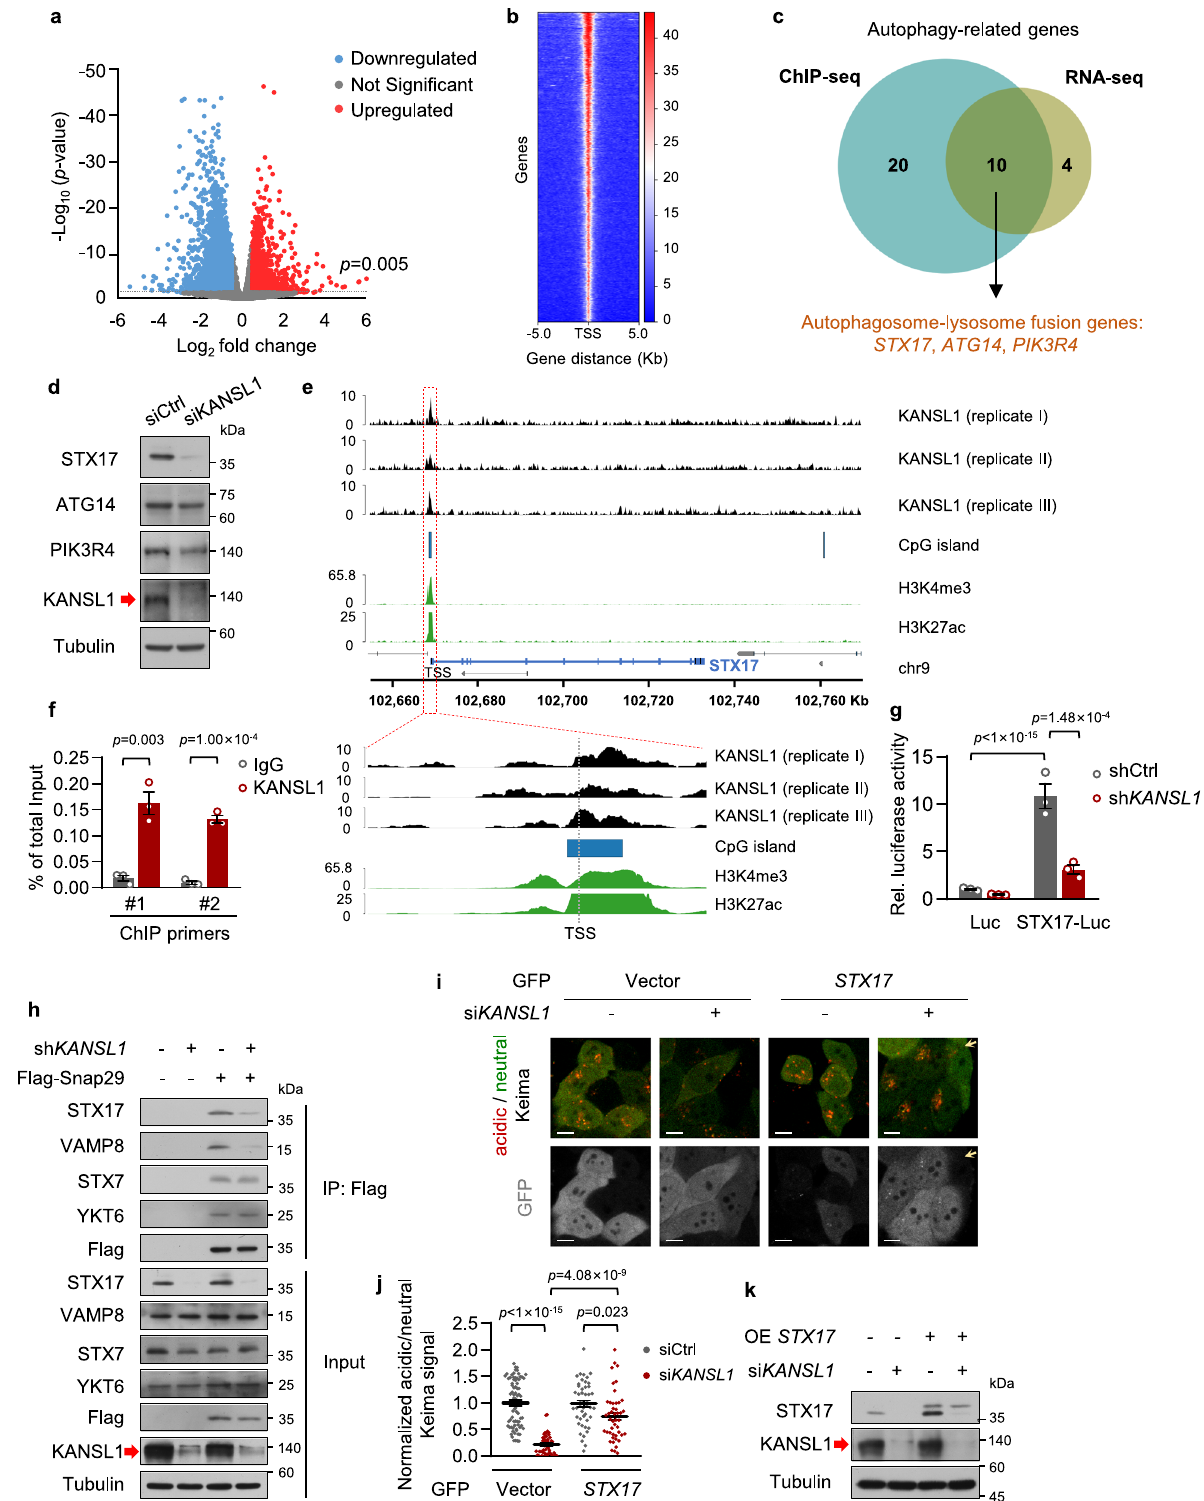
within ±5 kb proximal to the transcriptional start sites (TSS) (Fig. 3b). In total, TSS of 3637 overlapping genes were bound by KANSL1 among three independent ChIP-seq analysis. KEGG enrichment analysis of these genes also revealed that the ‘ SNARE interactions in vesicular transport ’ and the ‘ regulation of autop- hagy ’ pathways were enriched, including a total of 30 genes